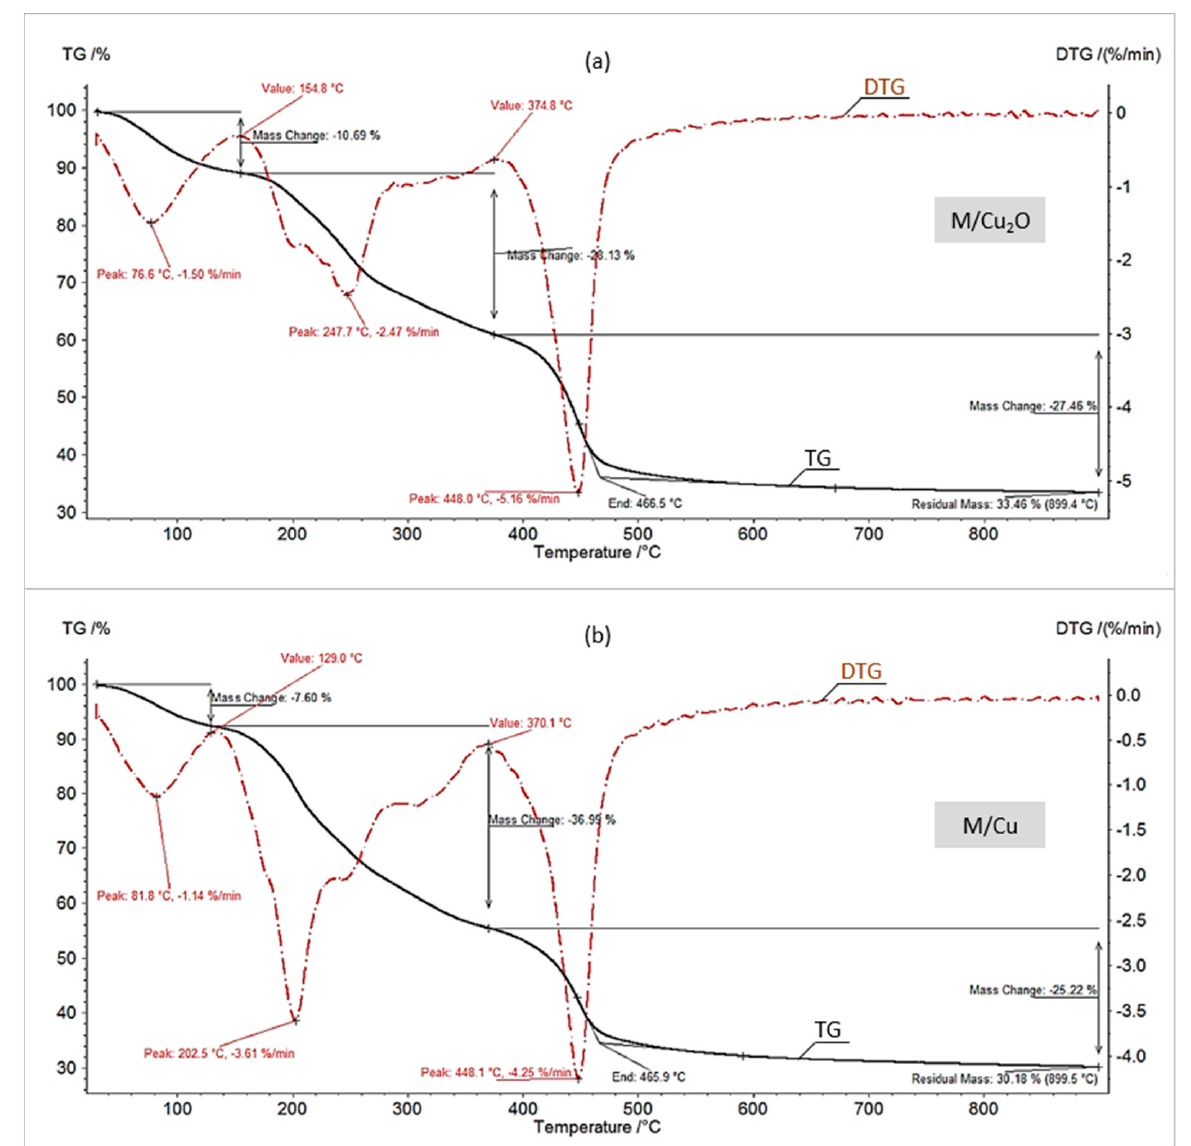
Figure 4. TG/DTG curves in N 2 of ( a ) M/Cu 2 O, ( b ) M/Cu.